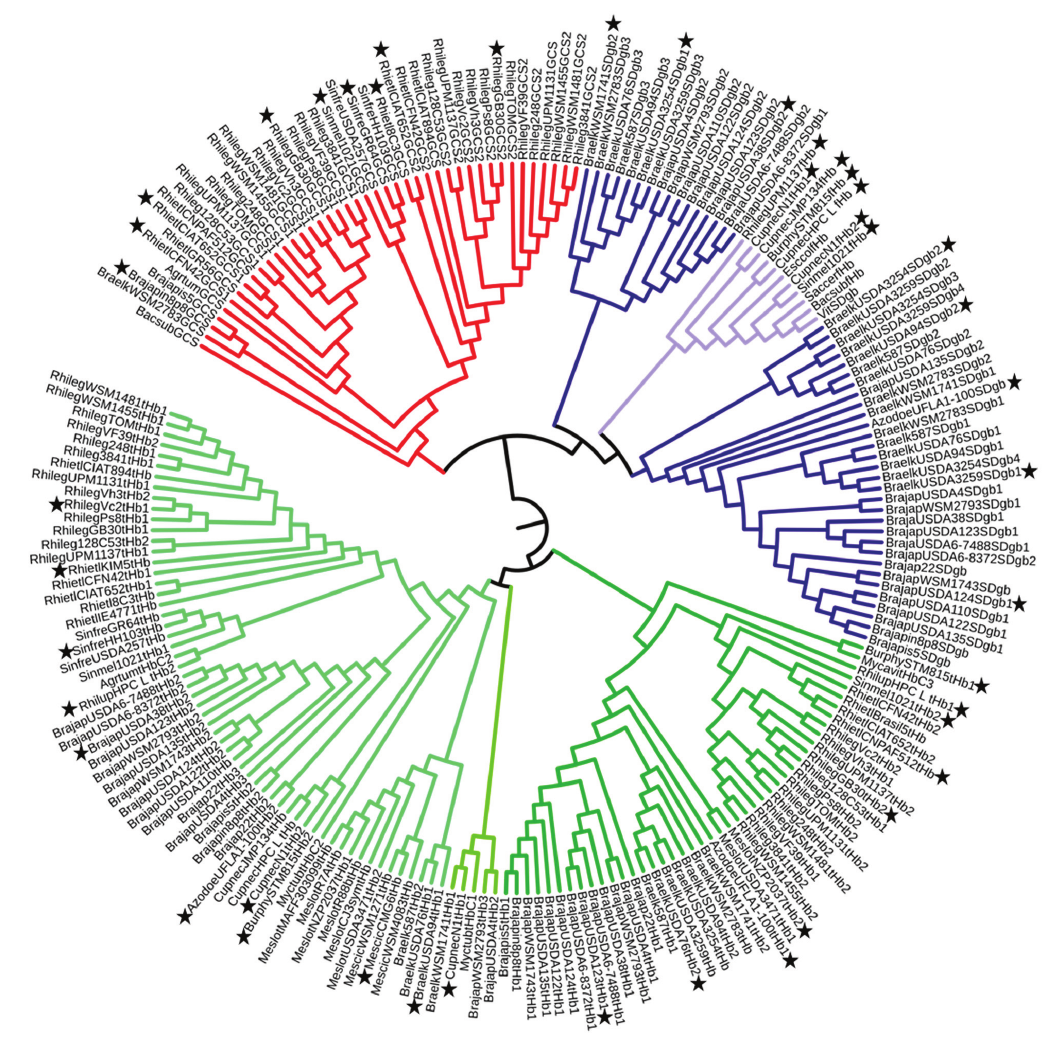
Figure 2. Phenetic relationships among Glbs detected in the genomes of rhizobial bacteria. Phenogram was obtained from the Glbs sequence alignment shown in Figure S2. The fHb, SDgb, GCS, tHb class 1, tHb class 2 and tHb class 3 clusters are indicated with light blue, dark blue, red, light green, bright green and dark green, respectively. Stars indicate Glbs selected for the detection of promoter sequences upstream to the glb genes and Glb protein